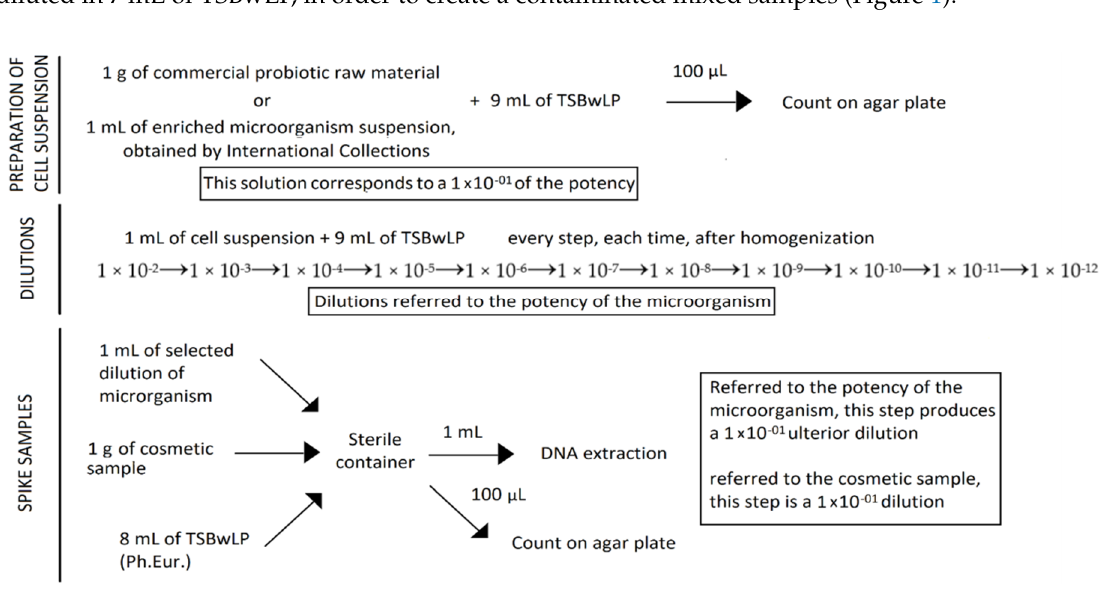
Figure 1. Representative scheme of preparation of spiked cosmetic samples.